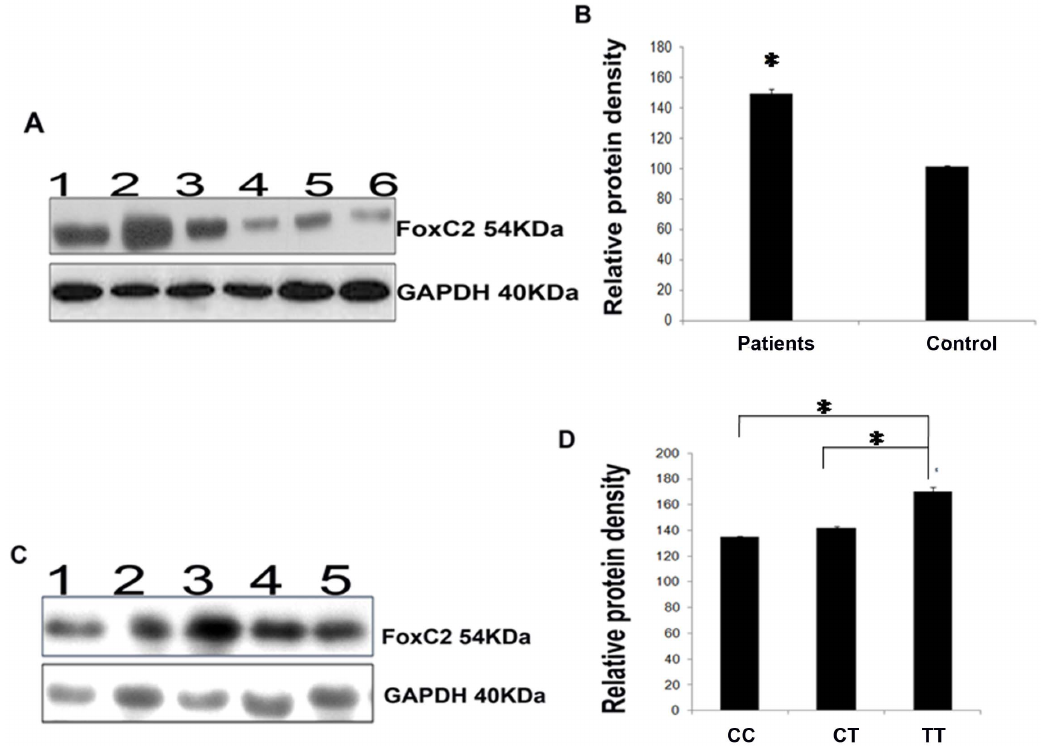
Figure 2. FoxC2 protein expression in saphenous vein tissues from patients with CVD and healthy subjects. (A) Immunoblot analysis of FoxC2 protein in patients and controls, lanes 1–3 patient vein tissue protein homogenates, lanes 4–6 control saphenous vein protein homogenates. (B) Densitometric analysis of immunoreactive bands indicates an upregulation of FoxC2 protein in vein specimens from patients (n=22) compared to controls (n=20). (C) Immunoblot analysis of FoxC2 protein in patients carrying lane 1: CC, lane 2–3: TT and lane 4–5: CT genotypes. (D) Graph showing a correlation of FoxC2 protein expression associated with CC, CT and TT genotypes of c.-512C . T (rs34221221) genotype in patients with CVD. FoxC2 protein was significantly increased in venous tissues of patients carrying TT genotype than those with CC and CT genotypes of c.-512C . T variant (*p , 0.01). Data shown are the mean 6 SD.